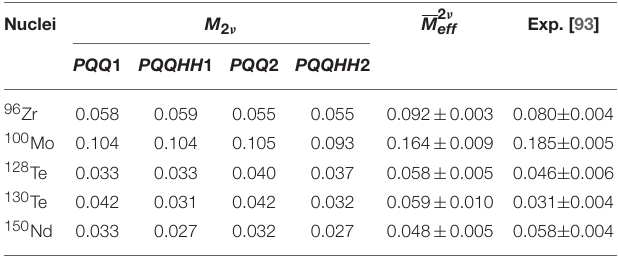
TABLE 2 | Theoretically calculated NTMEs M (2 ν ) with four different parametrizations of the effective two-body interaction along with experimental recommended values